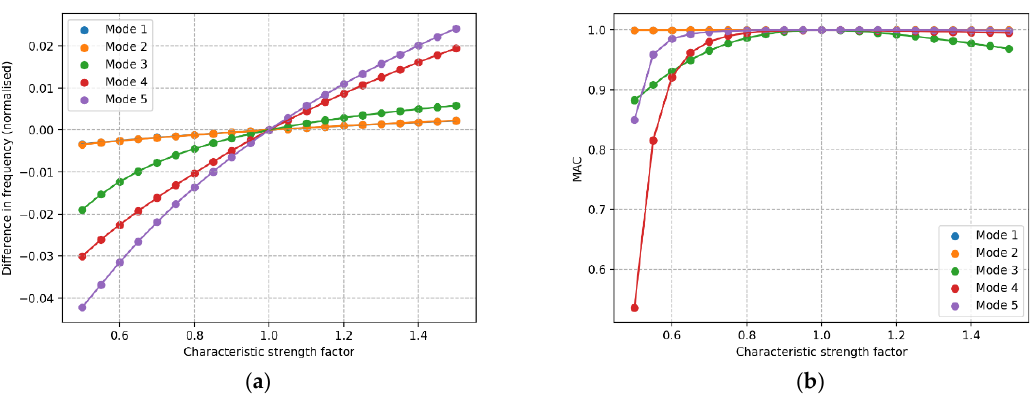
Figure 14. Characteristic soil strength sensitivity. ( a ) Difference in frequency, ( b ) MAC value.